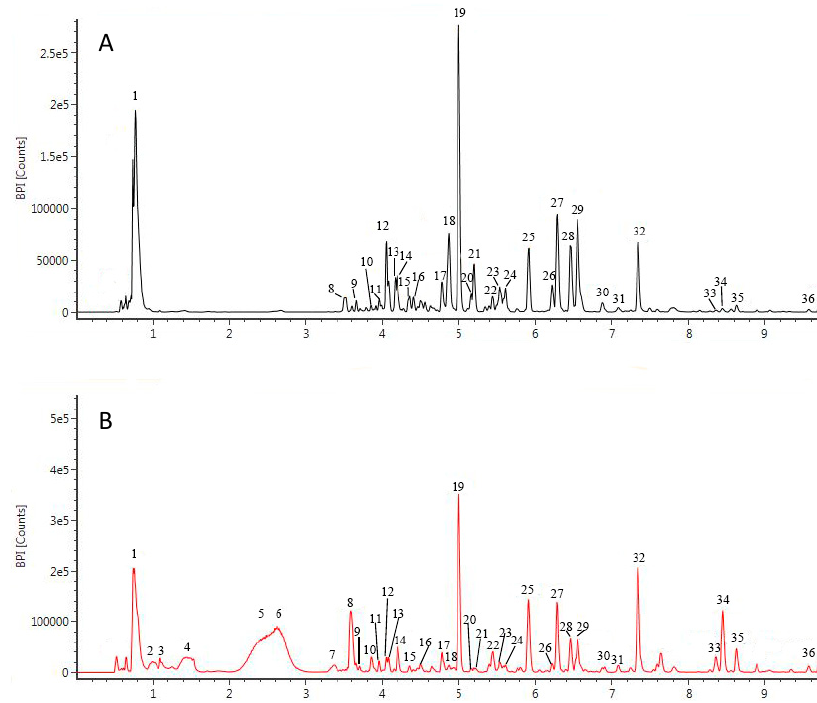
Figure 3. The base peak ion chromatograms (BPI) of soaked ( A ) and germinated ( B ) peanut extracts. Numbers indicate peaks of compounds found in extracts.